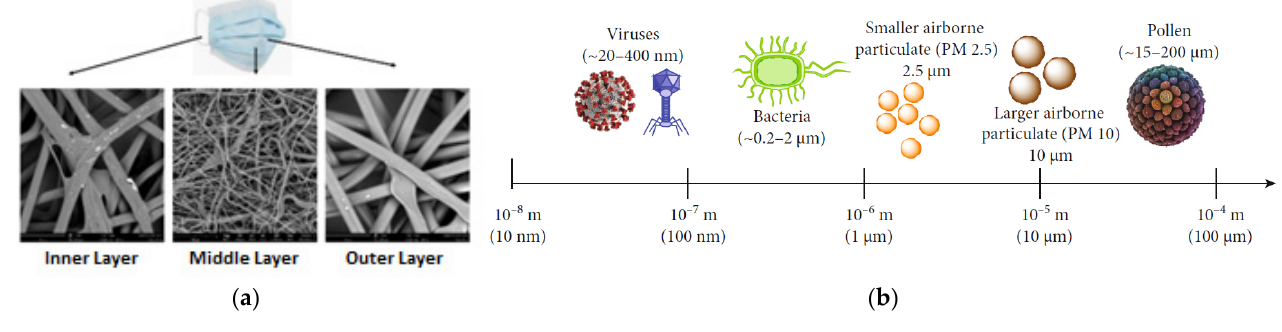
Figure 4. ( a ) SEM images of a surgical face mask [81] and ( b ) Sizes of common airborne contaminants and pathogens [73]. and pathogens [71].